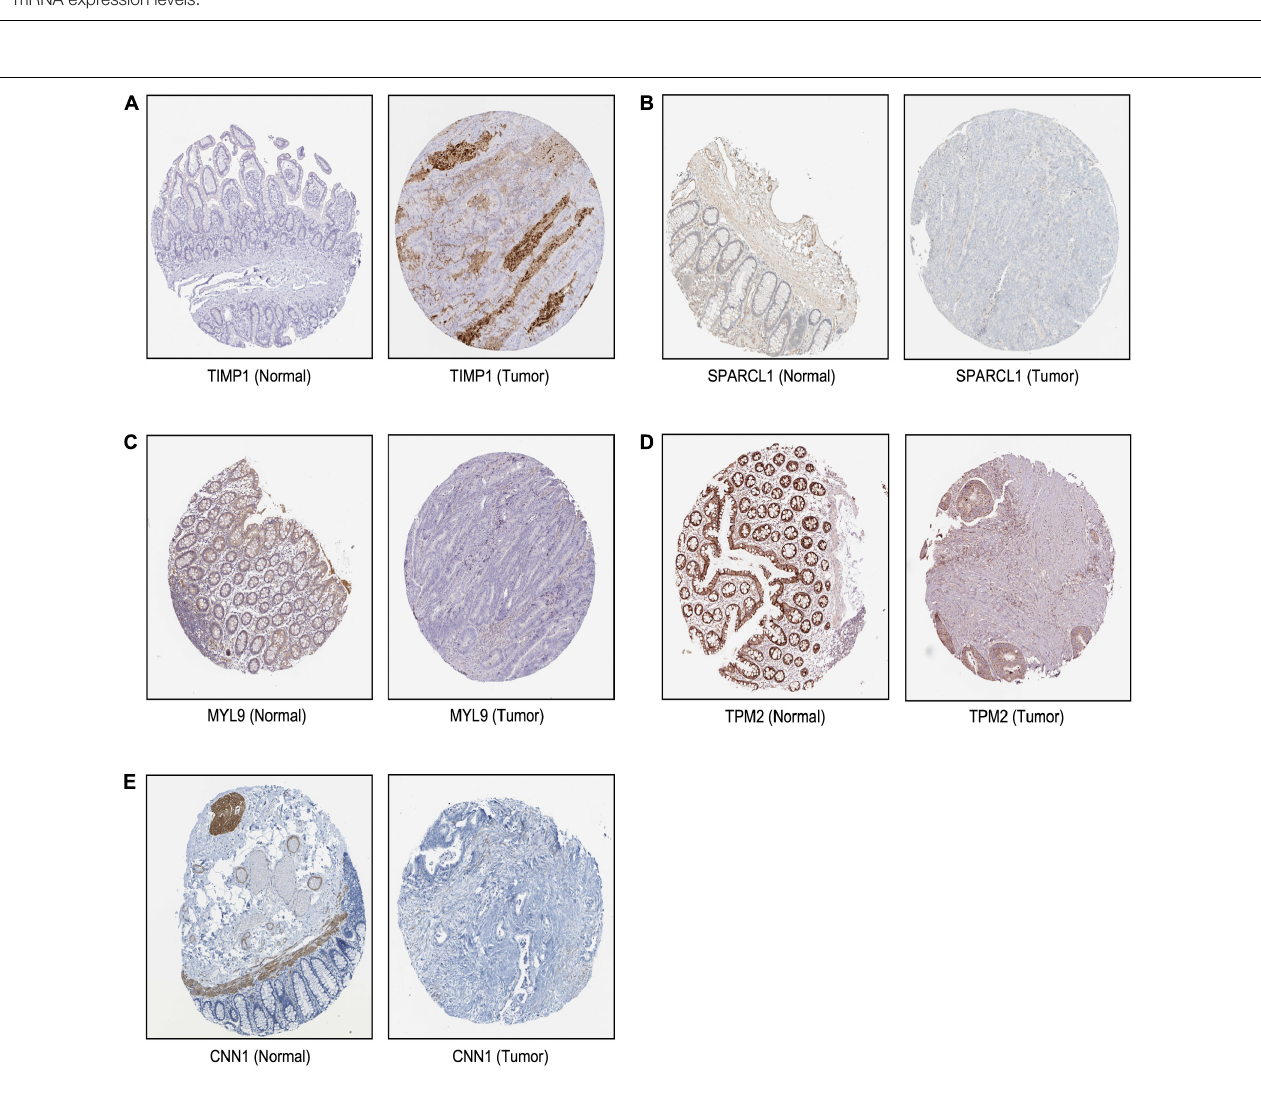
FIGURE 8 | The translational differences of five hub genes in CRC. The expression of (A) TIMP1, (B) SPARCL1, (C) MYL9, (D) TPM2, and (E) CNN1 on translational levels in CRC tissues compared with normal colon tissues from The Human Protein Atlas database (immunohistochemistry).